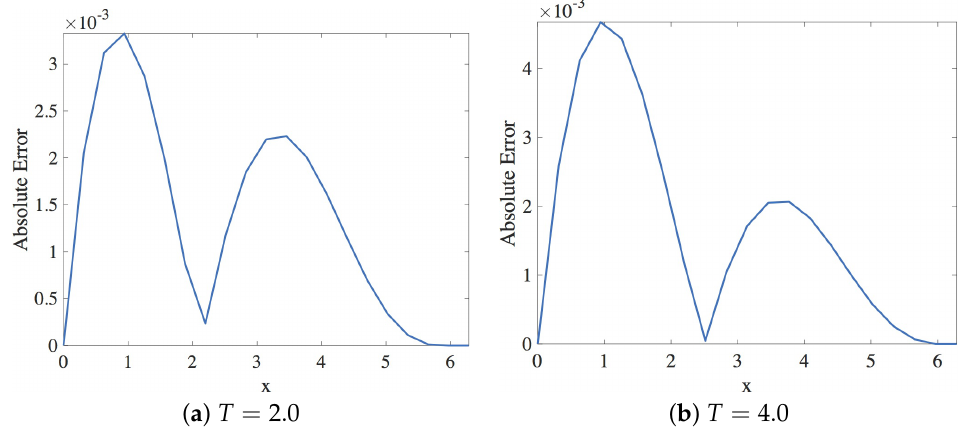
Figure 24. Plot of the absolute error vs. x using Scheme 2 for Numerical Experiment 2. The spatial and temporal step sizes are h = π /10 and k = 0.001,